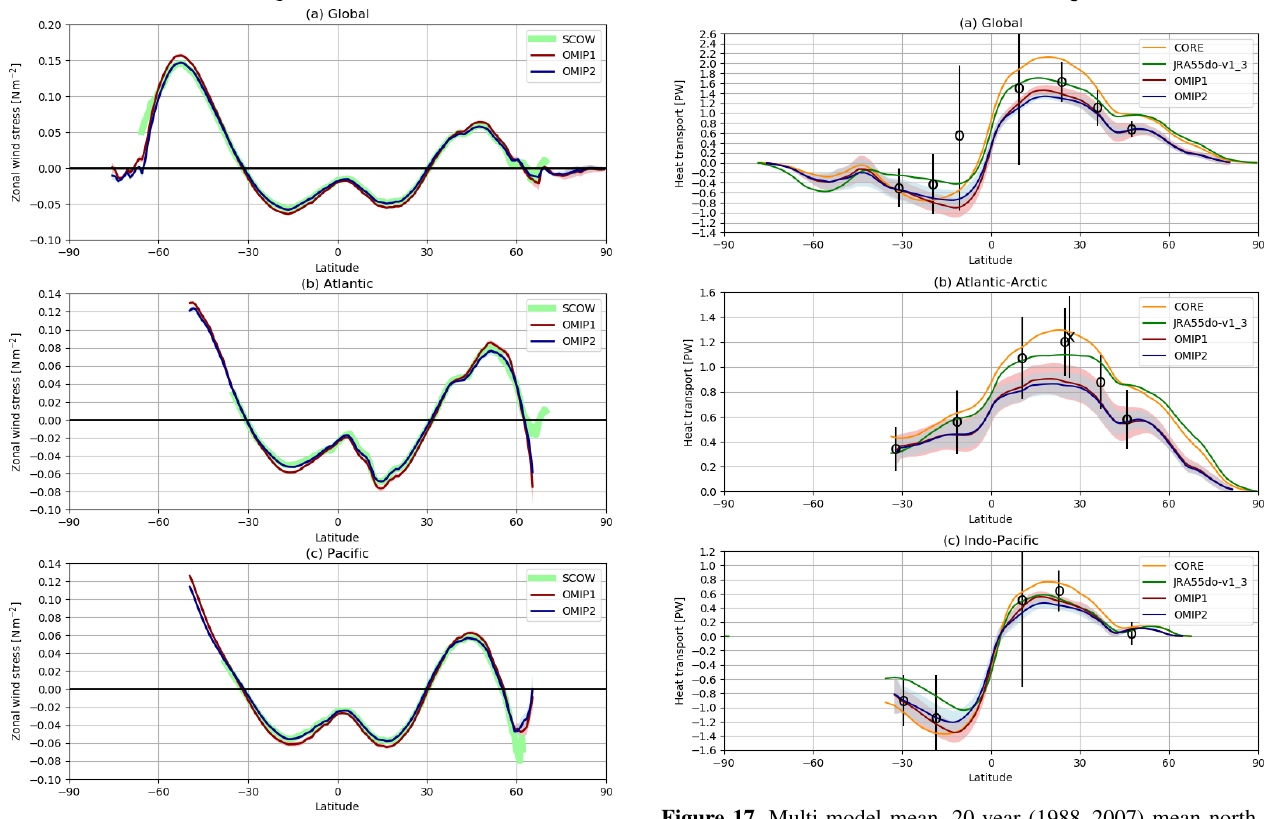
Figure 16. Multi-model mean, 10-year (November 1999– October 2009) mean basin-wide averaged zonal wind stress (Nm − 2 ). (a) Global ocean, (b) Atlantic Ocean, and (c) Pacific Ocean. Multi-model mean (lines) and spread defined as 1 standard deviation of the ensemble (shades) of OMIP-1 (red) and OMIP-2 (blue). Note that model spread is very small. Green bold lines are Scatterometer Climatology of Ocean Winds (SCOW) provided by Risien and Chelton (2008).